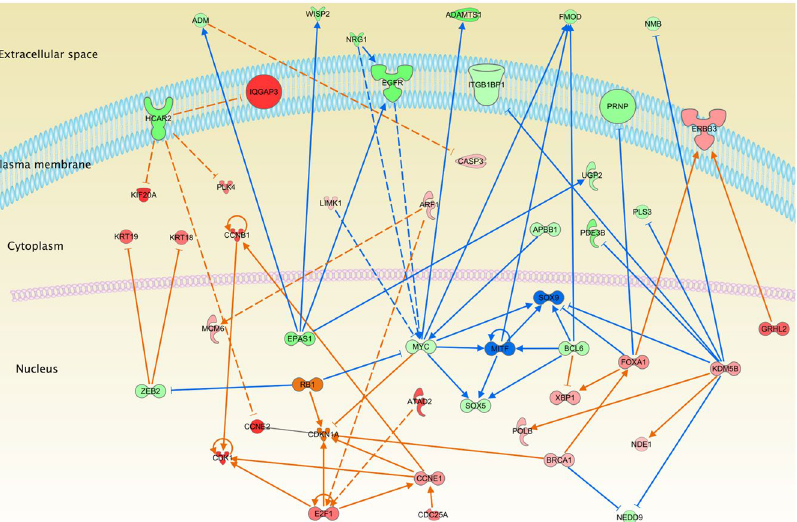
Figure 5. Ingenuity Pathway Analysis cancer network from RNA-Seq breast cancer samples. The molecules color represents the expression levels: green/red stands for under/overexpressed in cancer samples respectively. Blue/orange color indicates a predicted inhibition/activation of the molecule respectively. Blue and orange lines are depicted with the same color code. Molecules color intensity is presented in log 2 FC scale. Notice that molecules in the extracellular space are underexpressed, whereas the inner components, in particular those that belong to the nucleus are